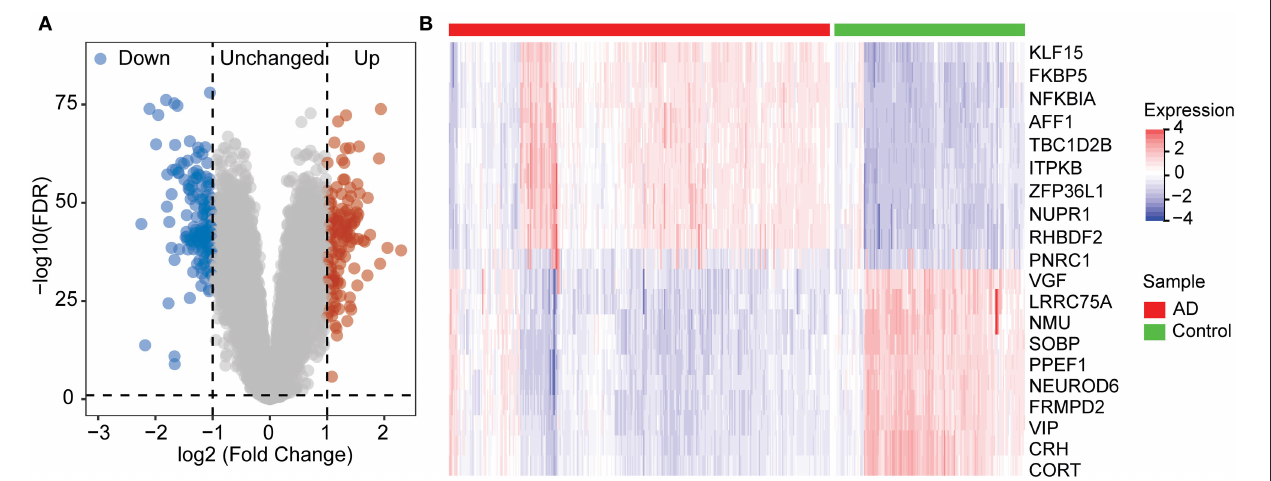
FIGURE2 Differentially expression gene between ND and AD samples. (A) Volcano plot showing the significant genes found by limma analysis. Red genes represent significantly high expression in AD, blue genes indicate significantly high expression in ND, and gray genes mean no changes. (B) The top 20 genes significantly expressed in AD or ND samples, showing by the